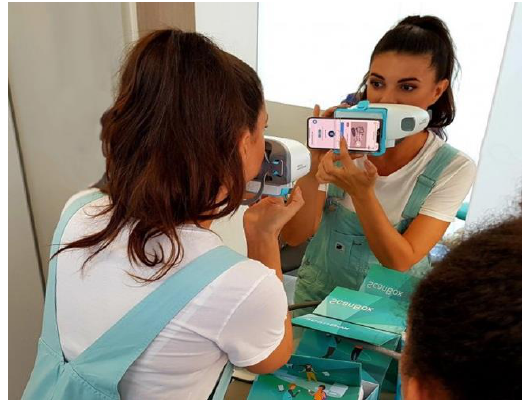
Figure 2. First Dental Monitoring session, in which the patient is educated with the nurse about how to use the free app in his/her own mobile in combination with the “scanbox” holder. Published with written consent of the person.